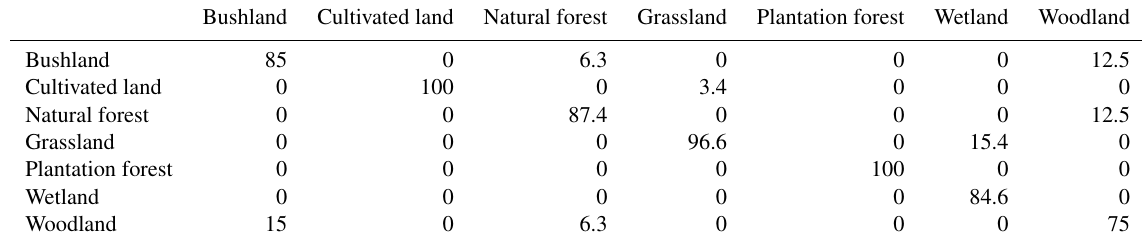
Table 1. Accuracy of vegetation identification (%). Bushland Cultivated land Natural